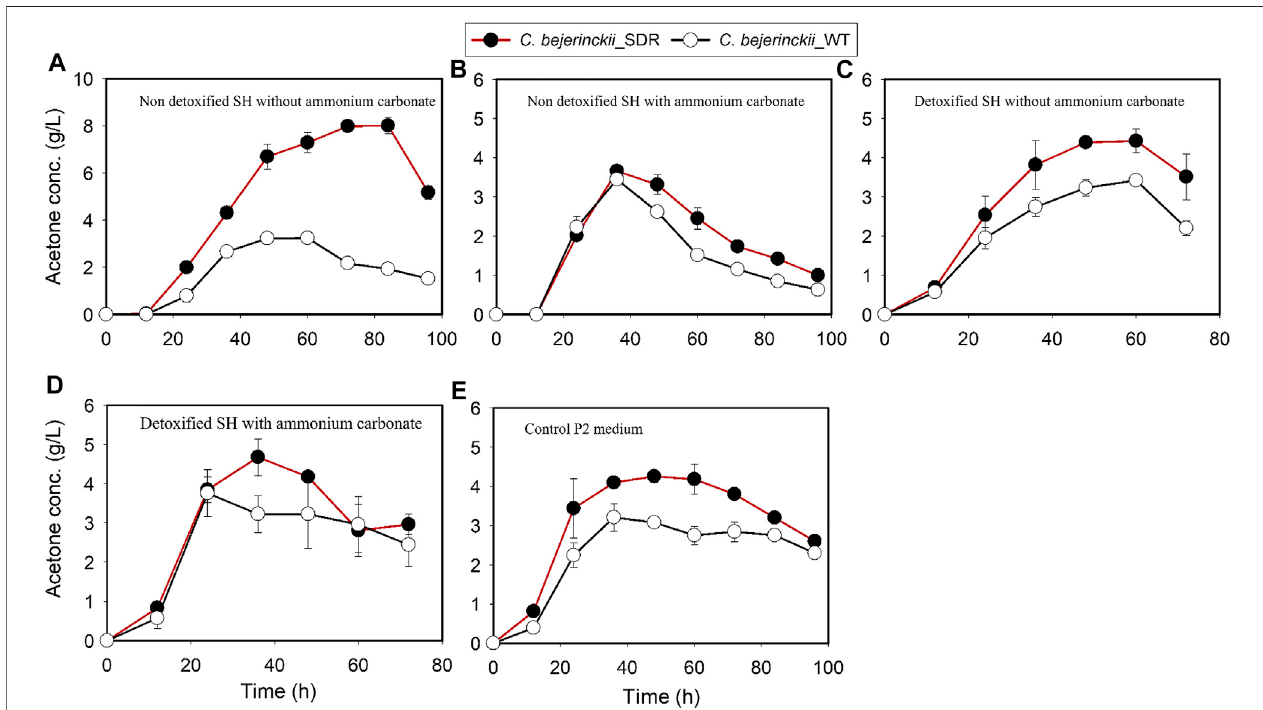
FIGURE5| Acetone concentrationpro fi les inculturesof C.beijerinckii _SDRor C.beijerinckii _wildtype grown inSHandP2medium control. (A) Non-detoxi fi edSH without ammonium carbonate. (B) Non-detoxi fi ed SH with ammonium carbonate. (C) Detoxi fi ed SH without ammonium carbonate. (D) Detoxi fi ed SH with ammonium carbonate. (E) Control P2